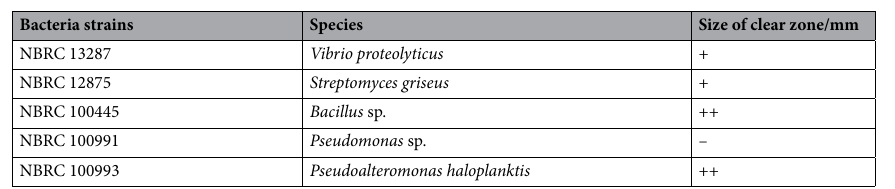
Figure 3. 2D WAXD images of ( a ) compression-molded BP1 ( b ) BP1 powder. ( c ) 1D WAXD patterns of the compression-molded BP1 (red line) and the BP1 powder (black line).